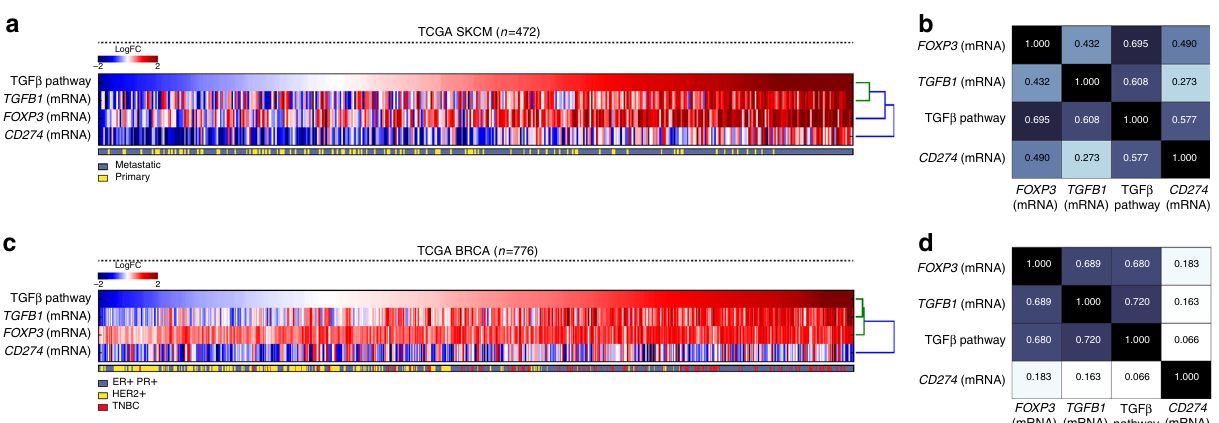
Fig. 1 TGF β pathway activation correlates with elevated TGFB1 and FOXP3 mRNA expression in TCGA-SKCM and TCGA-BRCA data sets. iPANDA software suite for analysis of intracellular signaling pathway activation based on transcriptomic data was used to estimate the level of TGF β signaling in melanoma or breast samples from TCGA-SKCM ( n = 472) and TCGA-BRCA data set, respectively ( n = 776). TCGA transcriptomic data from normal breast tissue ( n = 114) or skin biopsy of healthy women ( n = 122) was used as a reference after proper normalization. The TGF β pathway activation scores for a 472 melanomas (metastatic and primary) and c 776 breast tumors (ER/PR positive, HER2 positive, and TNBC) are sorted from low to high. The corresponding expression of TGFB1 gene, FOXP3 , and CD274 is shown for each patient. The units on the color bar represent the pathway activation score or the fold change in the gene expression on the logarithmic scale in comparison with the average normal control level. Correlation matrix for melanoma ( b ) and breast cancer ( d ) are shown (numbers in plot indicate correlation coef fi cient value). Pairwise correlations between TGF β pathway activation and message for TGFB1 , FOXP3 , and CD274 were computed using the Pearson's correlation coef fi cient. The p -values were calculated with the null hypothesis that the tested samples are unrelated. The p -values for all correlation <